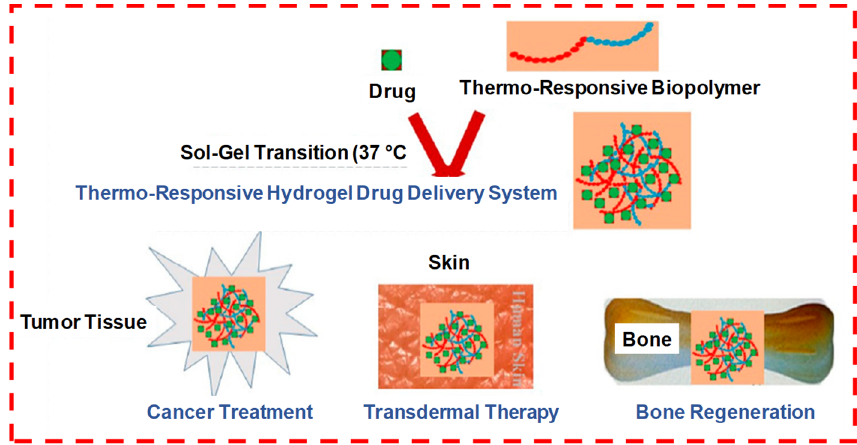
Figure 14. The formation of a drug-loaded biopolymer-based thermo-responsive hydrogel system via in situ gel formation and its biomedical applications, including cancer treatment, transdermal therapy and bone regeneration. Adapted with permission from ref. [5]. Copyright © 2020 Polymers MDPI.